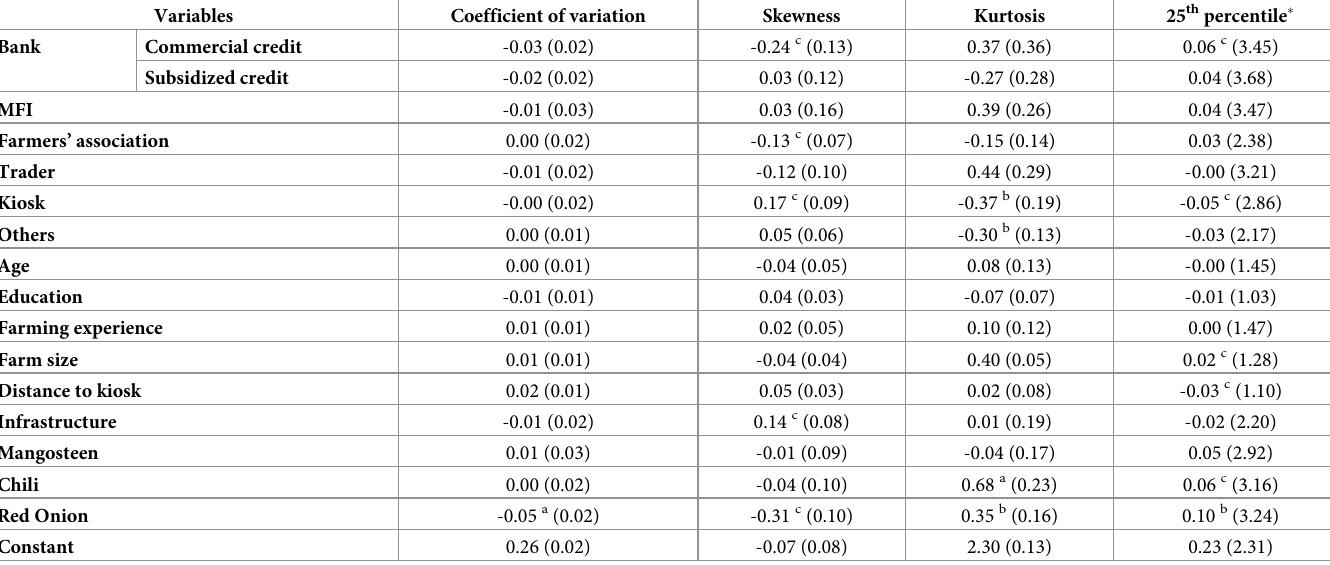
Table 3. Coefficients from the ordinary least square’s regression of production risk on the explanatory factors (standard errors in